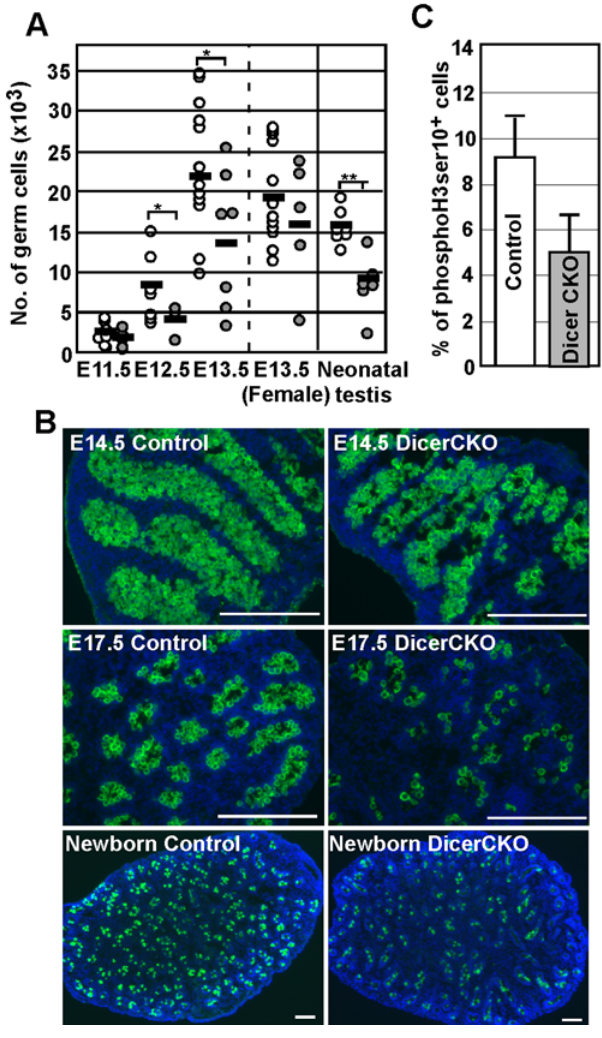
Figure 2. Defective proliferation of DicerCKO PGCs. (A) The number of PGCs in E11.5 , E13.5 gonads and in neonatal testes. A single dot shows the number of PGCs or germ cells in a pair of gonads or testes (open circles; Dicer F/ + TNAP-Cre, closed circles; DicerCKO). Black bar shows the mean. (B) Immunostaining for Mvh (green) in fetal and neonatal testis. The images are merged with DAPI (blue). Scale bar: 250 m m. (C) The reduced percentage of PGCs at M-phase in E12.5 DicerCKO male gonads. The percentages of PGCs immunostained for phosphorylated Ser10 of histone H3 are shown. Error bars represent standard deviation determined from three gonads.